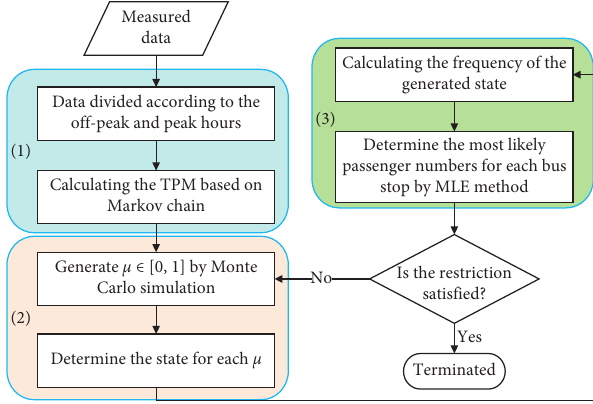
Figure 15: The procedure to synthesize a driving cycle for passengers.